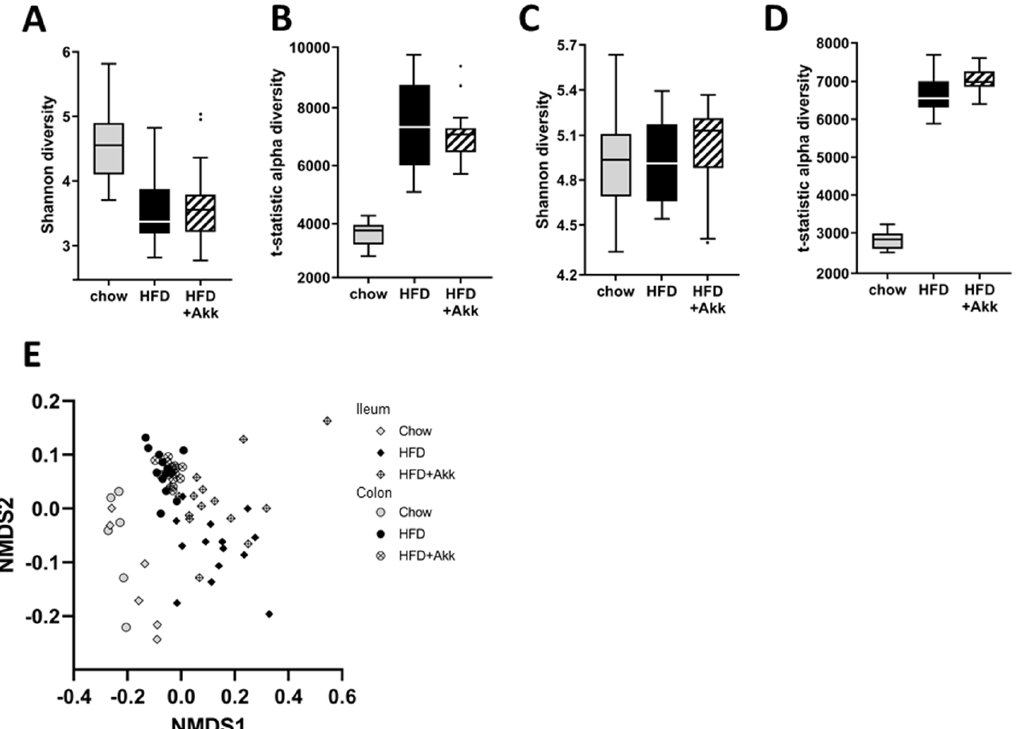
Figure 2. Heat-inactivated A. muciniphila has minor effects on mucosal gut microbiota in ileum and colon. Ldlr − / − .Leiden mice were fed a chow reference diet (chow) or a NASH-inducing high-fat diet without (HFD) or with supplementation of heat-inactivated A. muciniphila (HFD + Akk) for 28 weeks. ( A ) Shannon index (sensitive for high-abundance bacteria) in ileum; ( B ) tail statistic (t-statistic; sensitive for low-abundance bacteria) in ileum; ( C ) Shannon index in colon; ( D ) tail statistic in colon; ( E ) visualization of total microbiota ordination in ileum and colon with non-metric multidimensional scaling (NMDS) using the Bray–Curtis index.